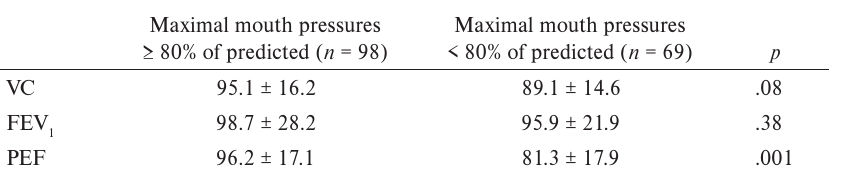
Ventilatory parameters in percentage of predicted in children with asthma with nor- mal and decreased respiratory muscle strength (mean ± SD) Maximal mouth pressures